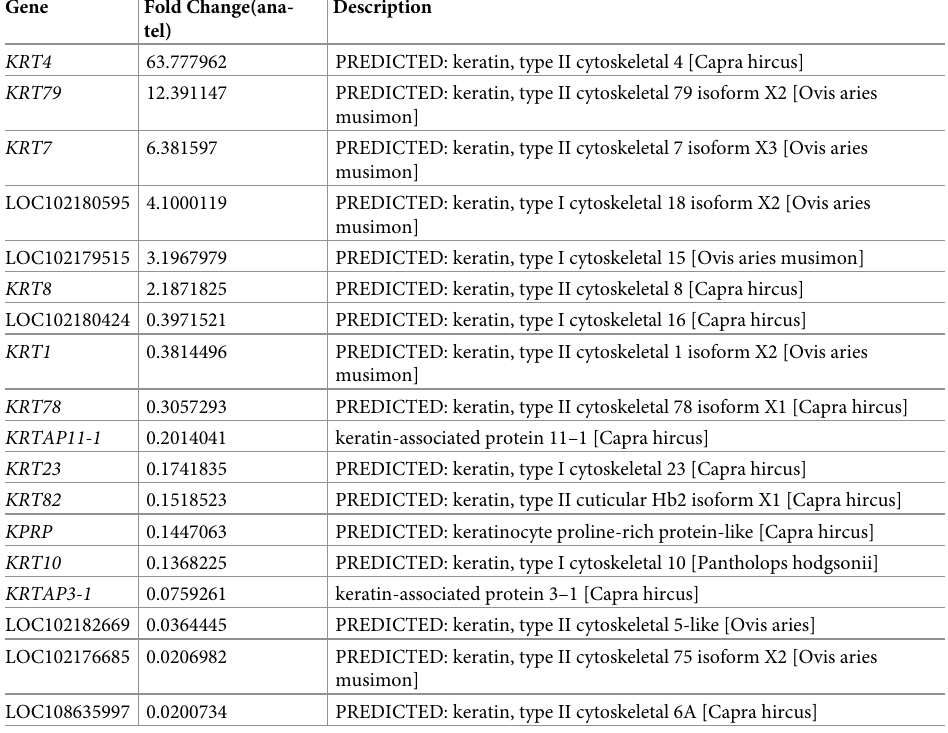
Table 3. KRT and KRTAP , which were annotated in Cashmere goat ( Capra hircus ) hair follicles. Gene Fold Change(ana-